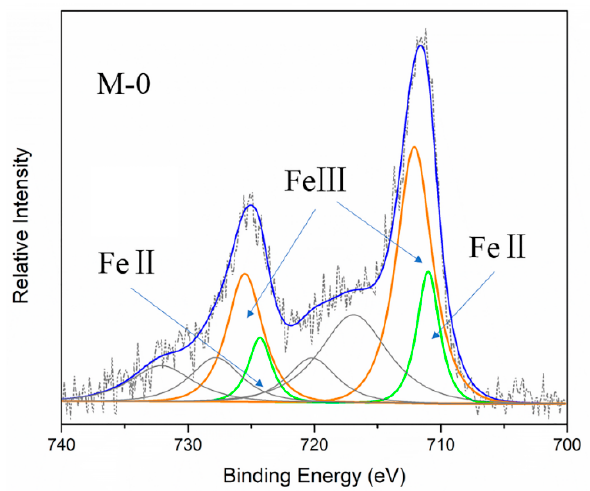
Figure 6. Fe2p high-resolution spectra of as-prepared MIL-101(Fe).